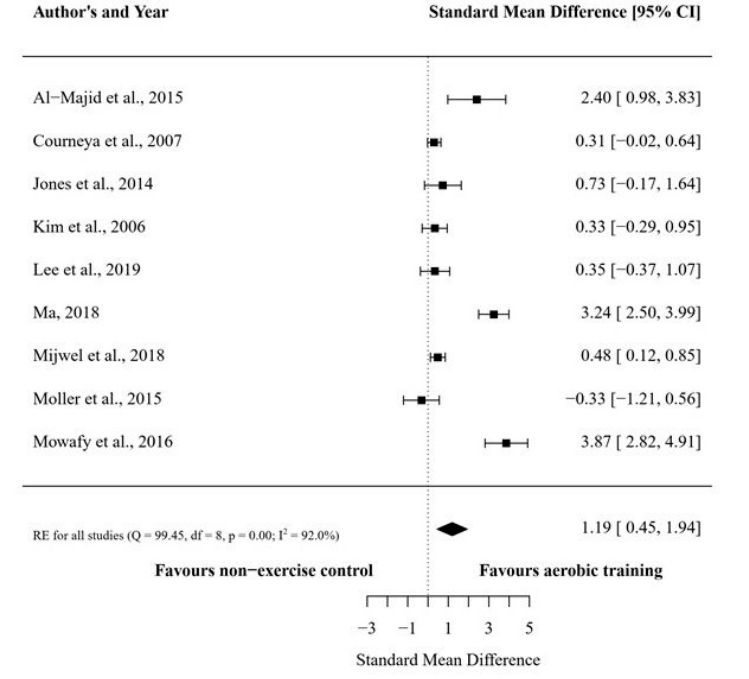
Figure 3. Forest plot for maximum oxygen consumption (VO2max) between the structured aerobic training groups and usual care (no exercise) groups. Footnotes: data are shown as between-group effect size difference (d) and 95% confidence interval.